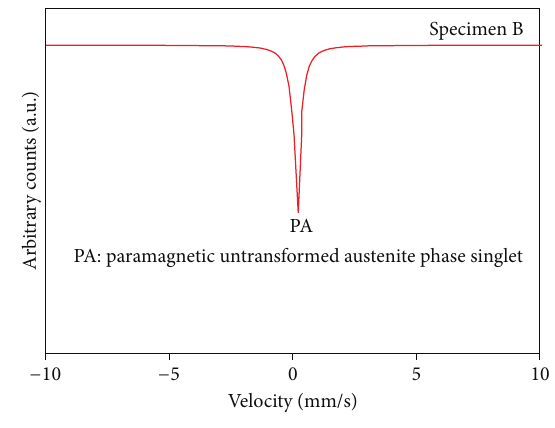
Figure 5: M¨ossbauer spectrum of specimen